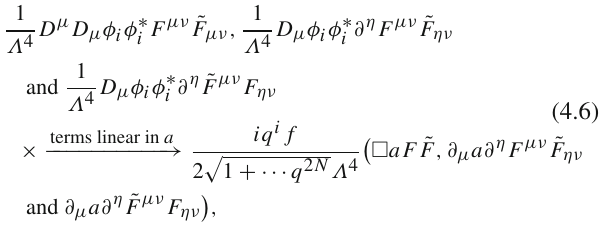
Fig. 4 Parameter space for a DM ALP of mass m a ≤ 10 − 2 eV when M c = M P (The pink region indicates the parameter space where (4.1) gives the DM relic density, whereas colored bands show where DM